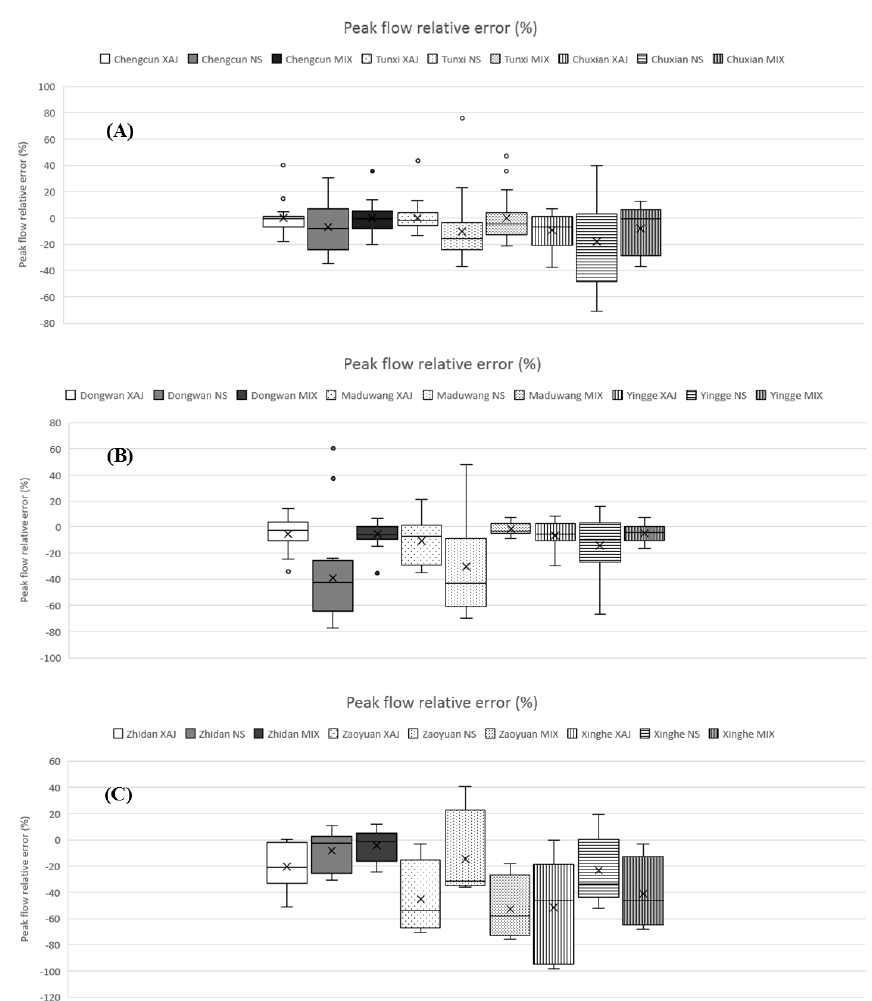
Figure 7. Boxplots of peak flow relative error; ( A ) humid regions; ( B ) semi-humid semi-arid regions; ( C ) arid regions.